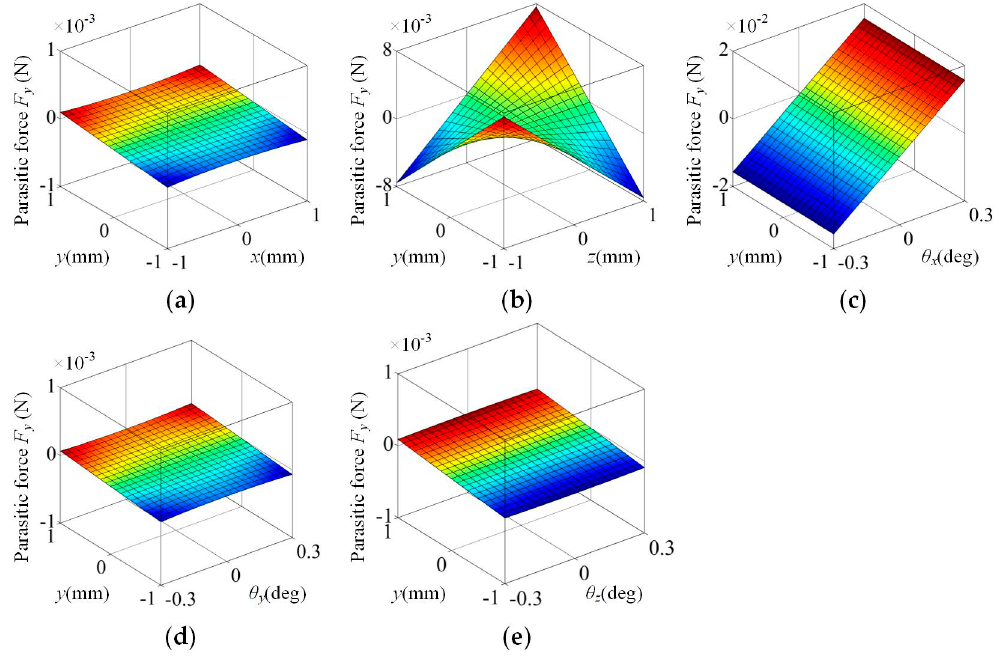
Figure 8. Parasitic force F y characteristic of the HMF-VCA varied with the mover’s motion. ( a ) F y vs. y and x . ( b ) F y vs. y and z . ( c ) F y vs. y and θ x . ( d ) F y vs. y and θ y . ( e ) F y vs. y and θ z .